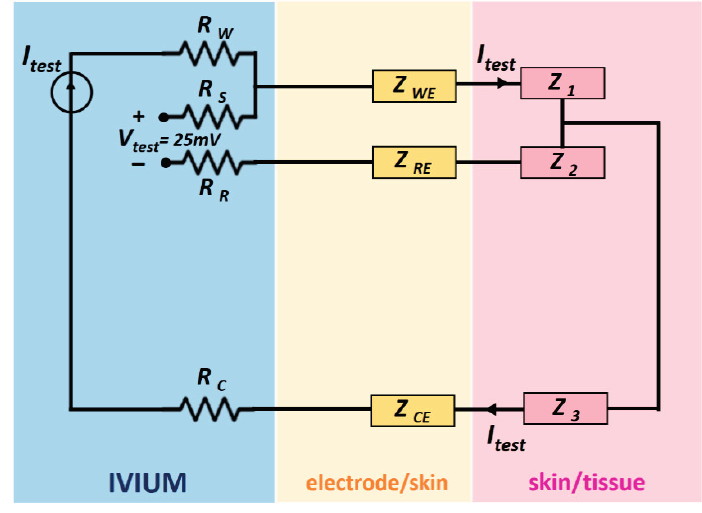
Figure 2. Schematic of the three-electrode set up for impedance measurement by the IVIUM